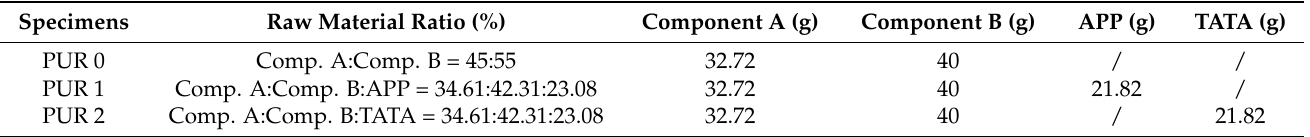
Table 1. Compositions of the